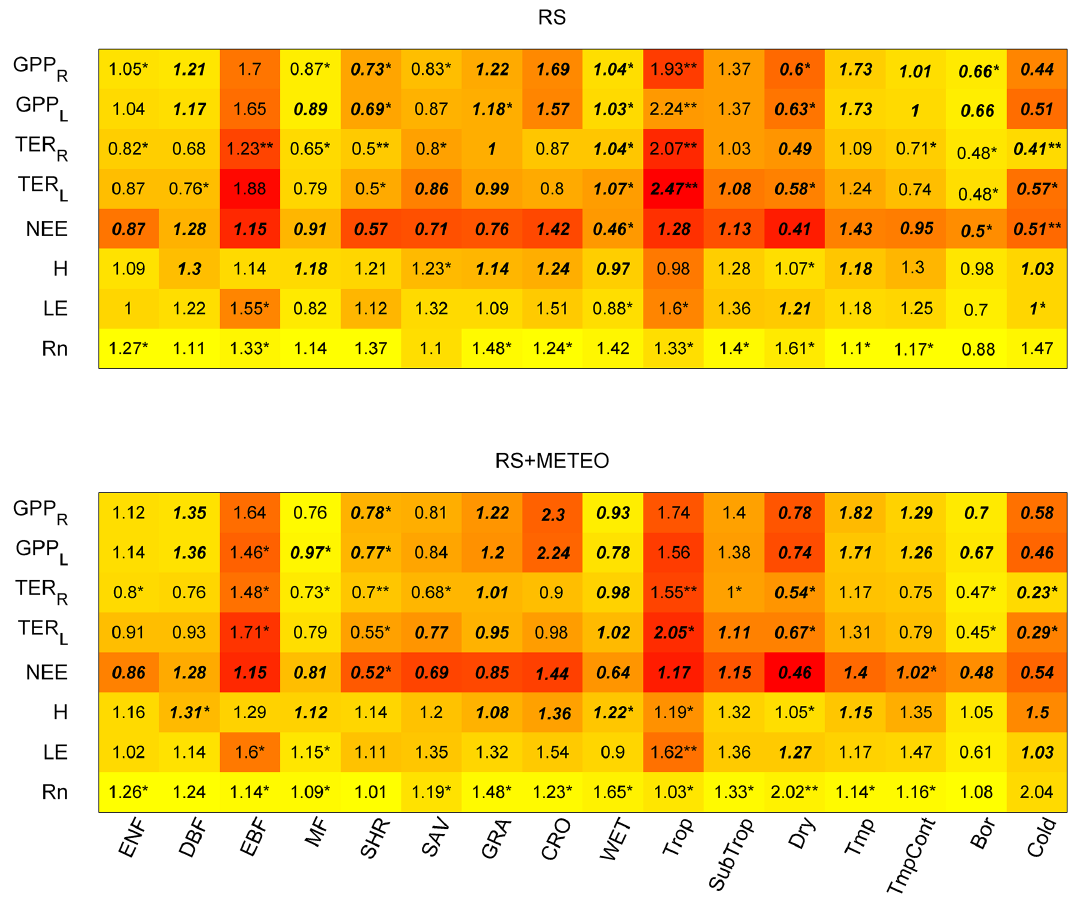
Figure 4. Performance of FLUXCOM median estimates per climate zone and plant functional type (PFT). The colored matrices show the median values of R 2 (red pixels for low R 2 , yellow pixels for high R 2 ) . Numbers indicate the RMSE (units of CO 2 fluxes are gCm − 2 d − 1 and MJm − 2 d − 1 in the case of energy fluxes). Oblique and bold fonts are used when the relative RMSE (normalized for the mean observed fluxes per PFT and climate zone) was greater than 0.5. The symbols “ ∗∗ ” after RMSE were used when the weight of bias (estimated as the ratio between the square of the median absolute bias and the MSE) was greater than 0.5; instead, “ ∗ ” symbols were used if the weight of bias was between 0.25 and 0.5. No symbols were used if the weight of bias is less than 0.25. List of acronyms: ENF, evergreen needleleaf forest; DBF, deciduous broadleaf forest; EBF, evergreen broadleaf forest; MF, mixed forest; SHR, shrubland; SAV, savannah; GRA, grassland; CRO, cropland; WET, wetland; Trop, tropical; SubTrop, subtropical; Dry, dry and arid land; Tmp, temperate; TmpCont, temperate–continental; Bor, boreal; Cold, cold and polar environment or covered by ice; GPP R and GPP L were, respectively, the gross primary production estimated following Reichstein et al. (2005) and Lasslop et al. (2010); TER R and TER L the total ecosystem respiration estimated following Reichstein et al. (2005) and Lasslop et al. (2010); NEE, net ecosystem exchange; H , sensible heat; LE, latent heat; and Rn, net